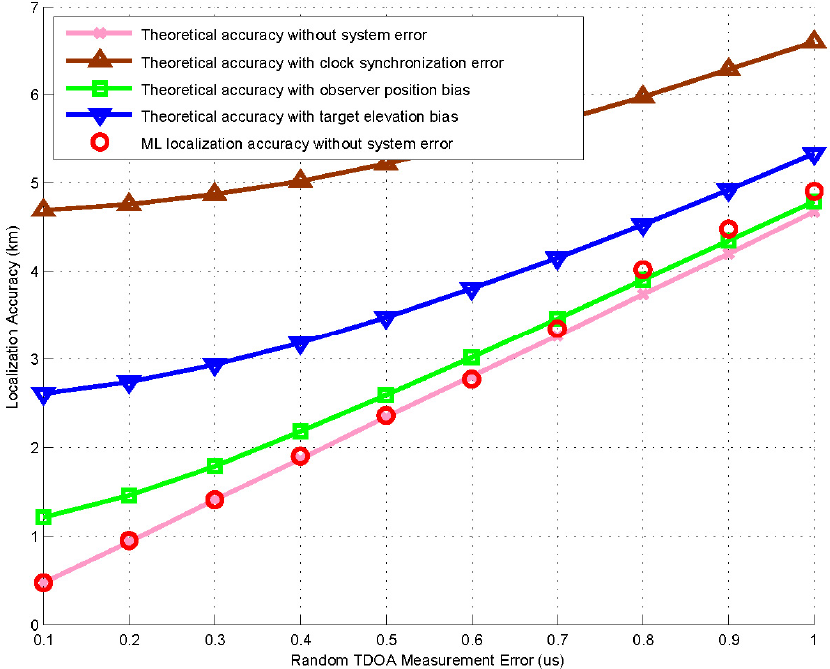
Figure 2. Localization accuracy comparison using the GEO and LEO satellites by varying TDOA measurement noise.